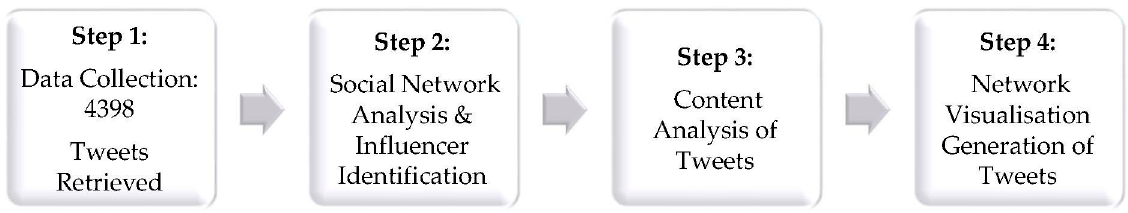
Figure 1. Summary of research methods.